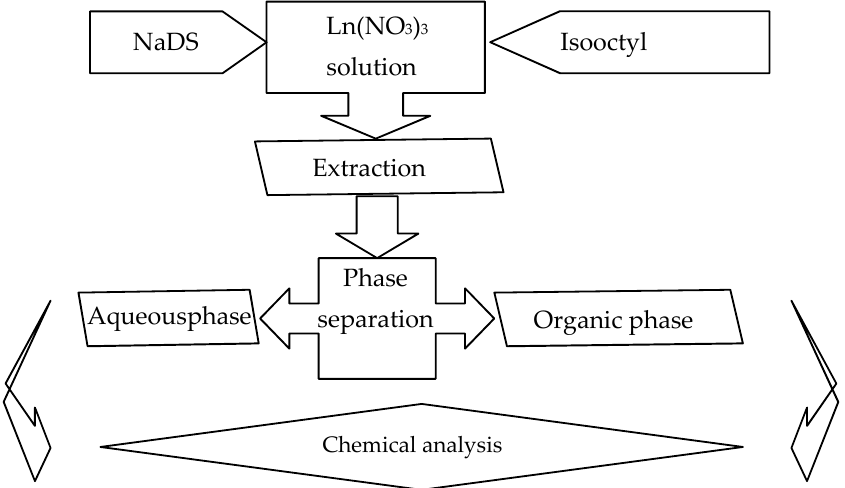
Figure 5. Scheme of the extraction process in the NaDS—Sm(NO3)3—2-octanol system.